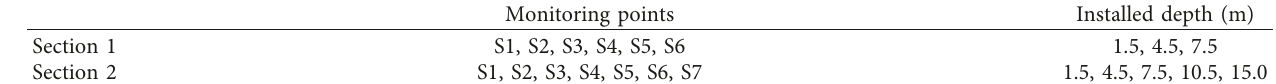
Table 1: Installed depth of layered settlement gauges.